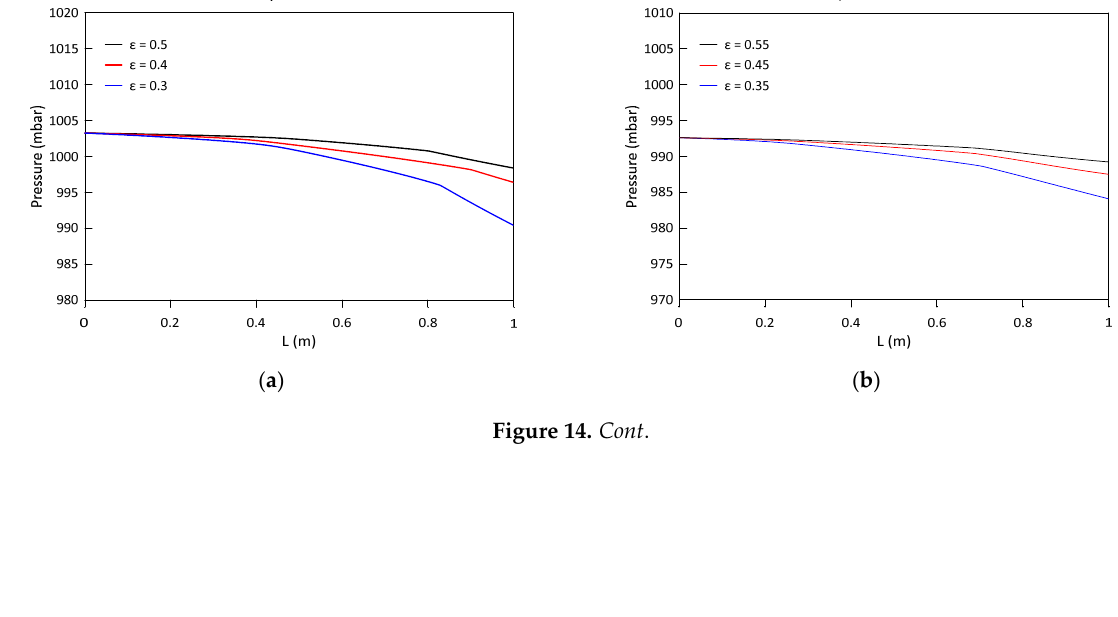
Olive Pomace Figure 14. Cont